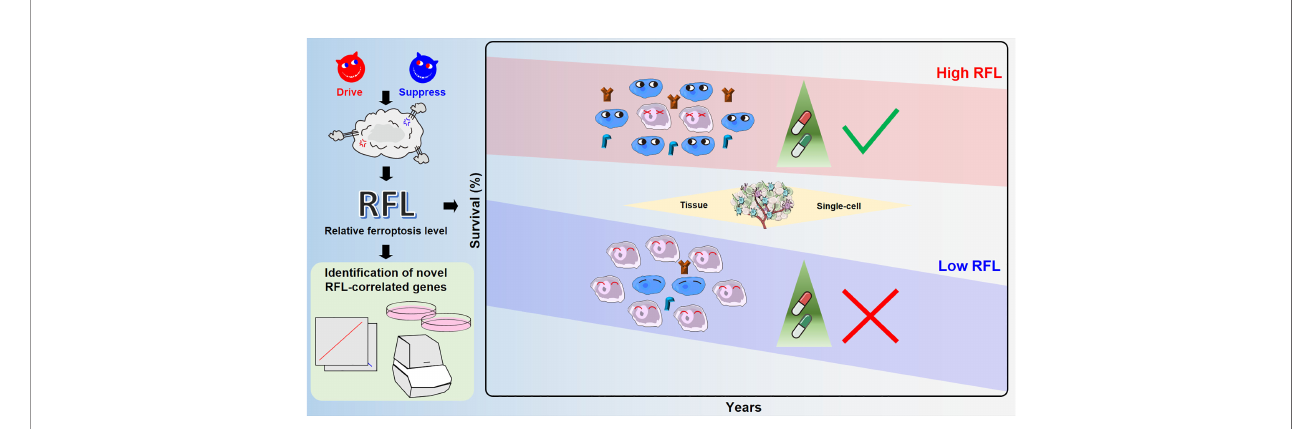
FIGURE 7 | Overview of ferroptosis-associated molecular features to aid patient clinical prognosis and therapy across